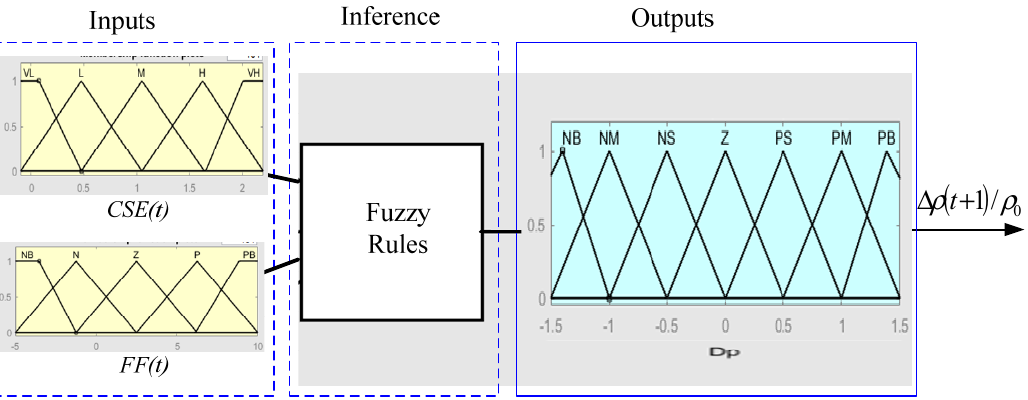
Figure 5. The FLC used for DR strategy. Table 1. The fuzzy rules that were used in the implementation of the FLC.